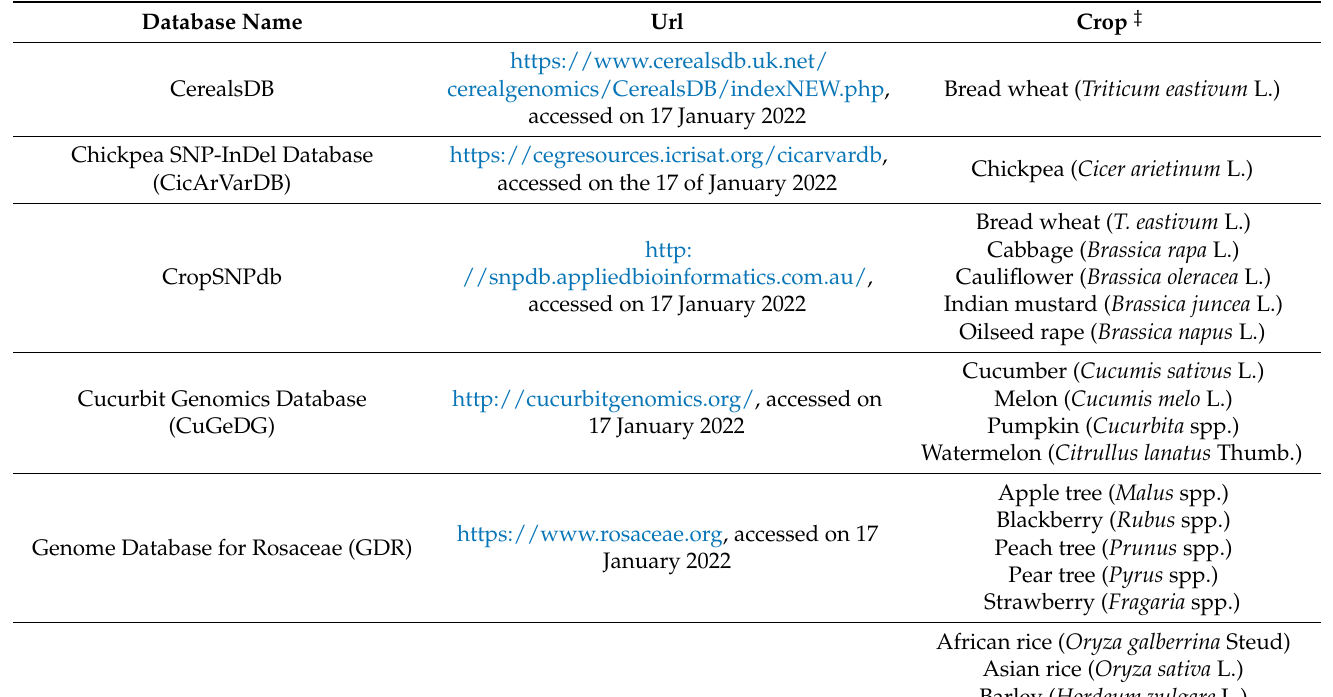
Table 1. List of the main public SNP databases in food crops. The type of information available ranges from the marker description to the genotype and map and/or genome